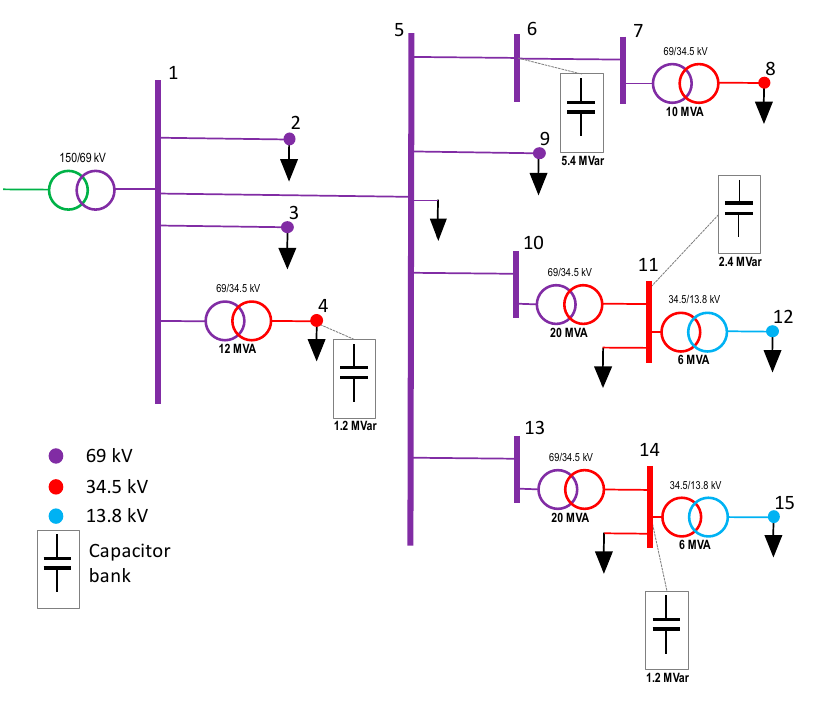
Figure 7. Case study without pattern control optimization (case a): capacitor configuration.